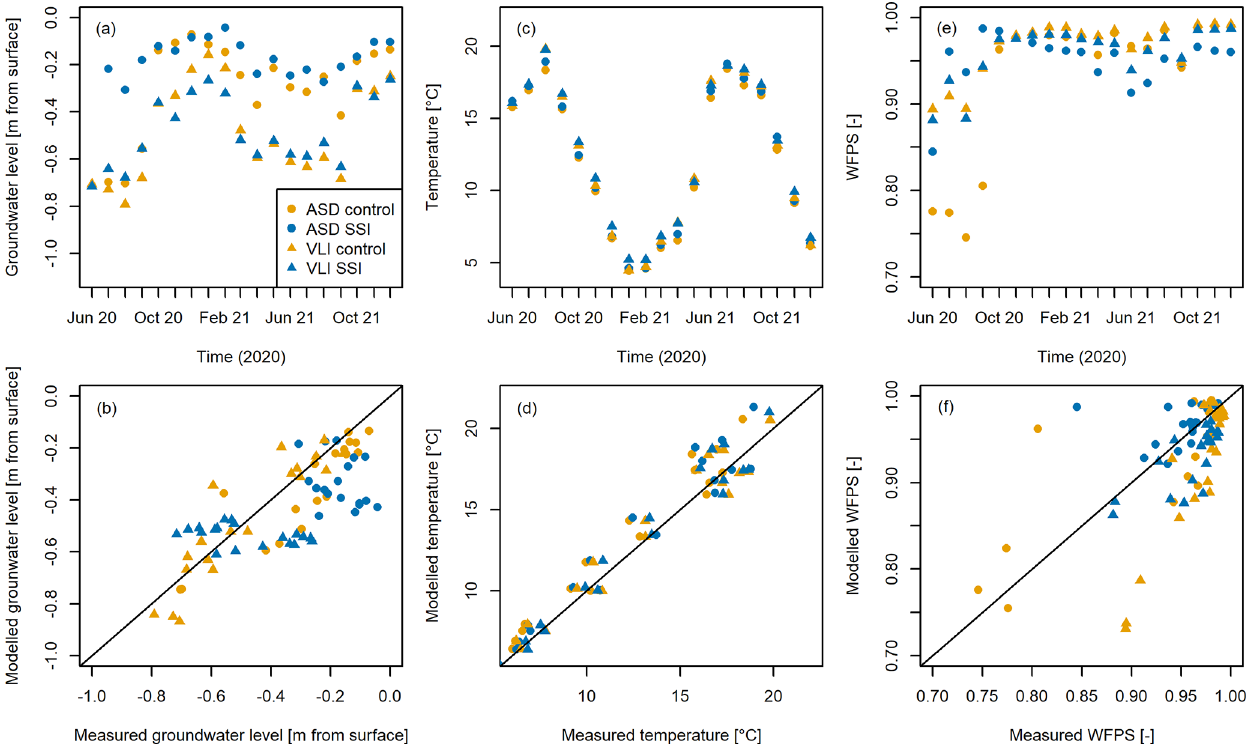
Figure 5. Monthly averages of measured (a) groundwater level, (c) soil temperature and (e) WFPS that are compared with monthly modelled averages of (b) groundwater level, (d) temperature and (f) WFPS. Values for temperature and WFPS were averaged over a depth of 0.4m. The legend in panel (a) applies to all